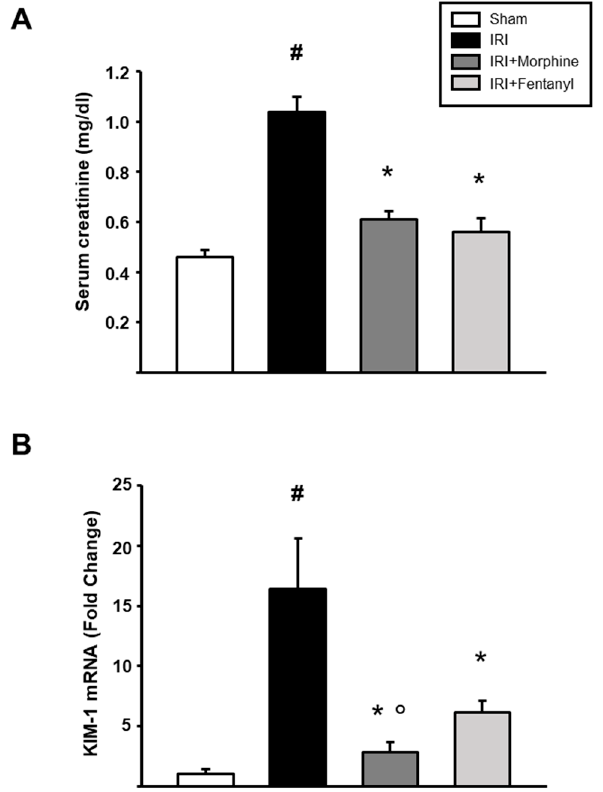
Figure 2. E ff ects of opioid preconditioning on serum creatinine and KIM-1 mRNA levels. ( A ) Serum creatinine was evaluated using a dry chemistry technique. ( B ) Renal expression of KIM-1 was evaluated by quantitative RT-PCR in the ischemia-reperfusion treated kidneys. HPRT was used as a housekeeping gene for normalization. The sham group is represented by the white bars, IRI by the black bars, IRI + morphine by the dark gray bars, and IRI + fentanyl by the light gray bars. Values are means ± S.E.M. ( n = 6). # p < 0.05 vs. sham, * p < 0.05 vs. IRI, ° p < 0.05 vs. fentanyl.